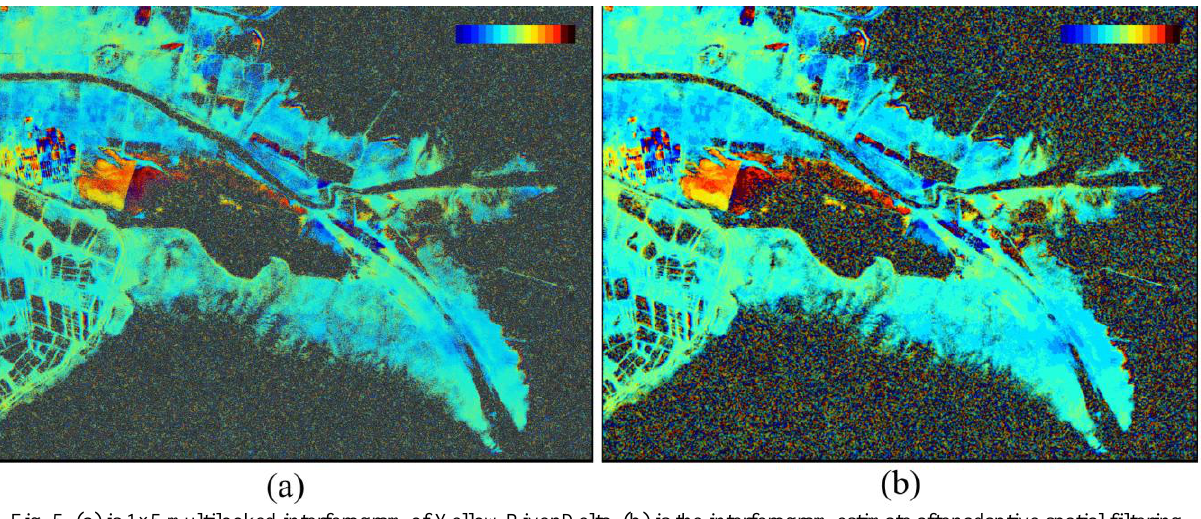
Fig. 5. (a) is 1×5 multilooked interferogram of Yellow River Delta, (b) is the interferogram estimate after adaptive spatial